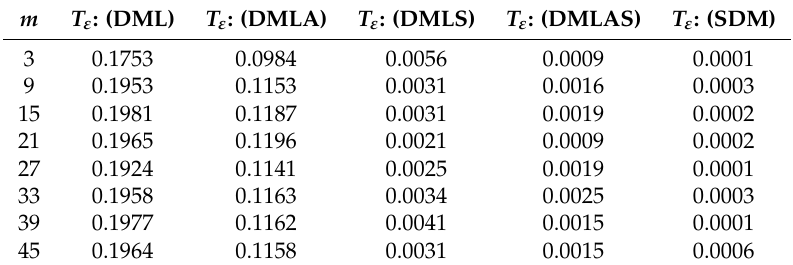
Table 6. Results for Case QL with J = 510, ε = 10 − 2 .